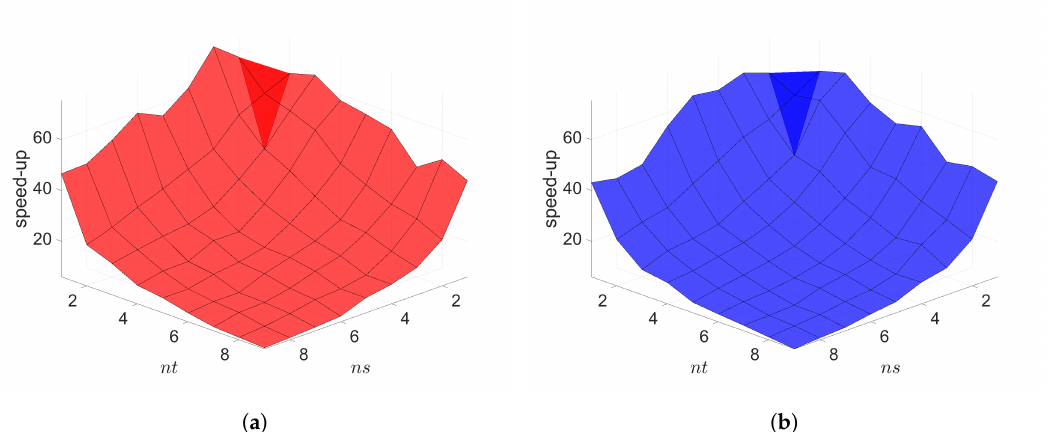
Figure 14. 2D linear convection diffusion equation. Online speed-ups vs. reduced dimensions. Both Galerkin and LSPG show similar speed-ups. ( a ): Online speed-ups vs. reduced dimensions for Galerkin projection, ( b ): Online speed-ups vs. reduced dimensions for LSPG